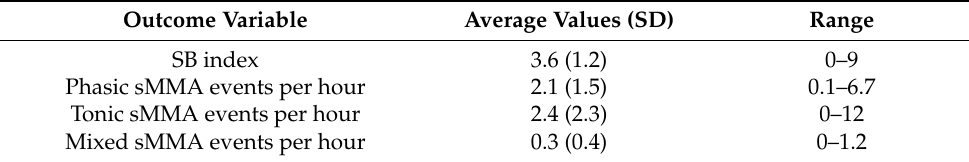
Table 1. Descriptive statistics of outcome variables during the four recording nights. Outcome Variable